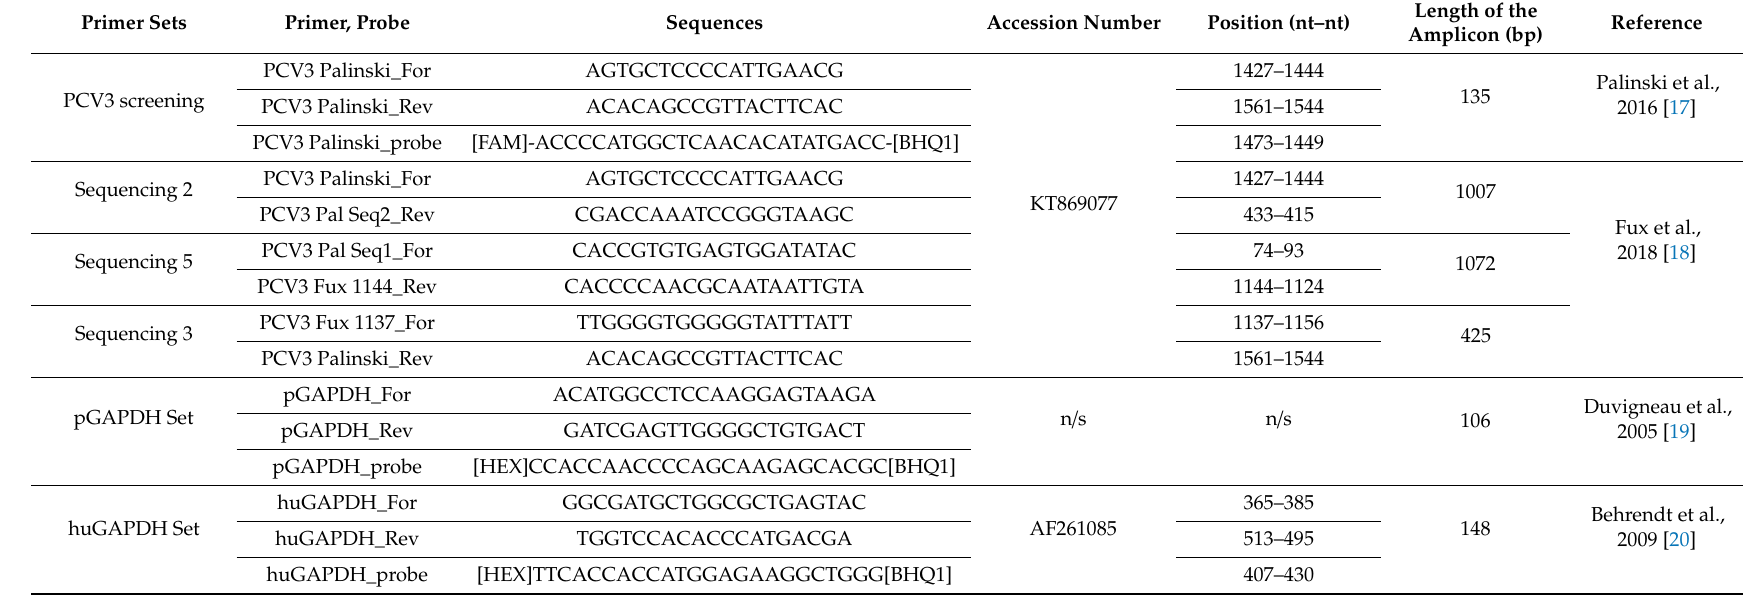
Table 1. Primers and probes used for PCV screening and